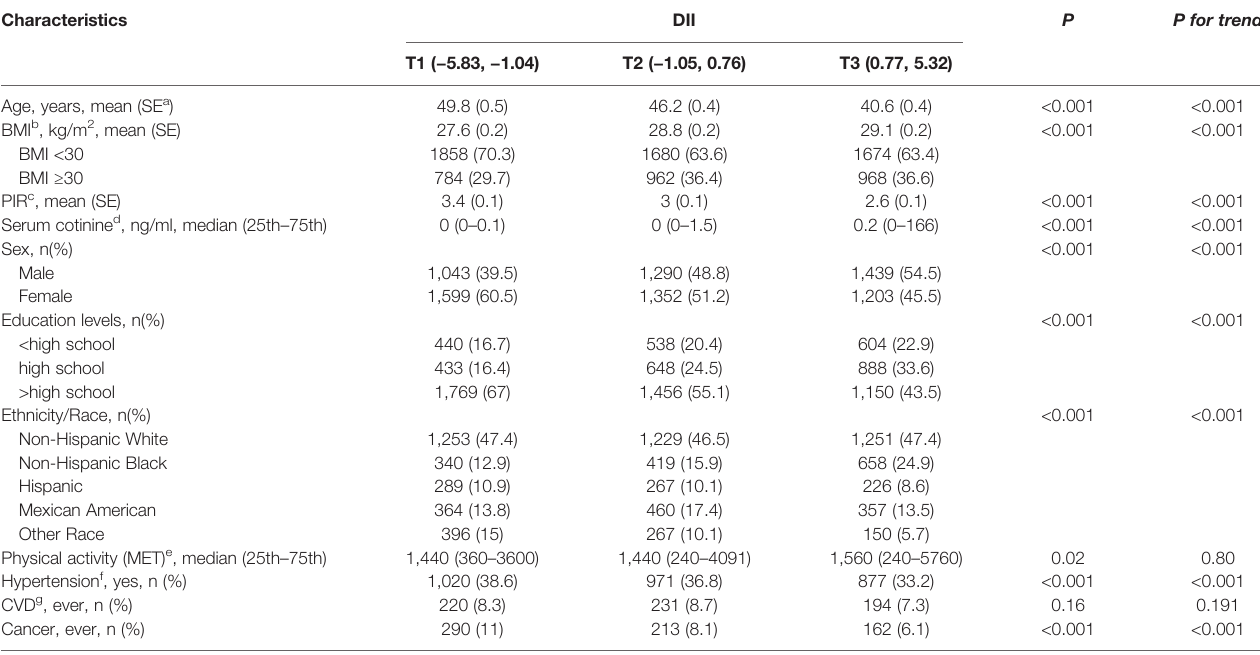
TABLE 1 | Demographic characteristics of adults aged 18 years and older according to the tertiles of dietary in fl ammatory index (National Health and Nutrition Examination Survey 2007 – 2016).